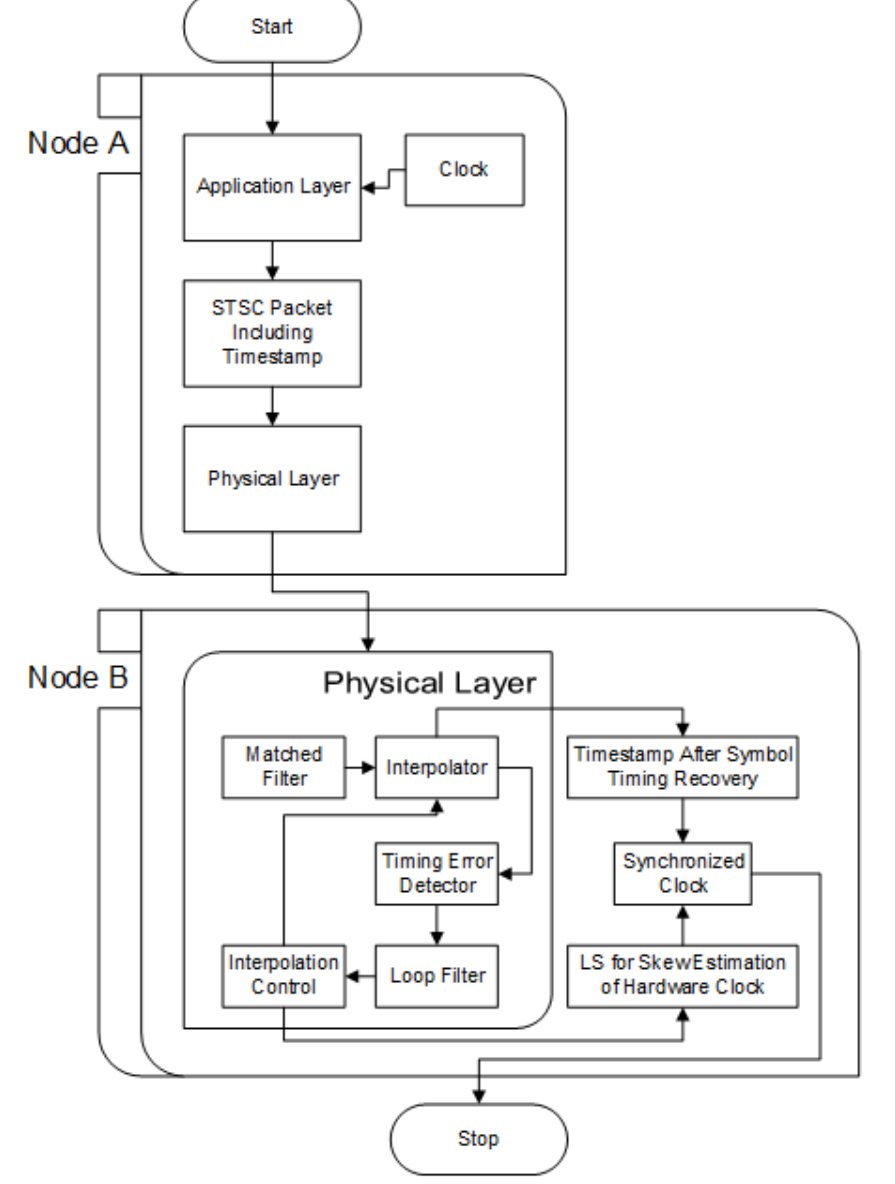
Figure 2. Flowchart of the single-timestamp skew-correction (STSC)